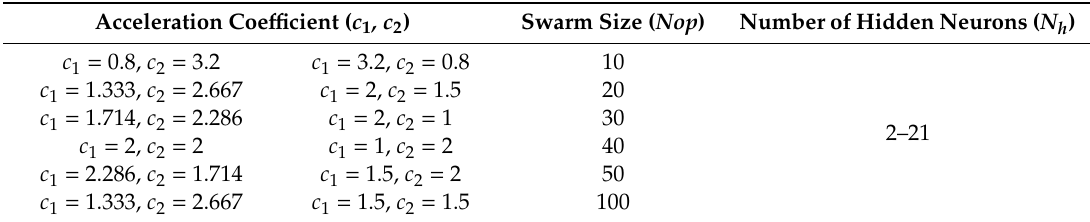
Table 3. Values of the PSO parameters